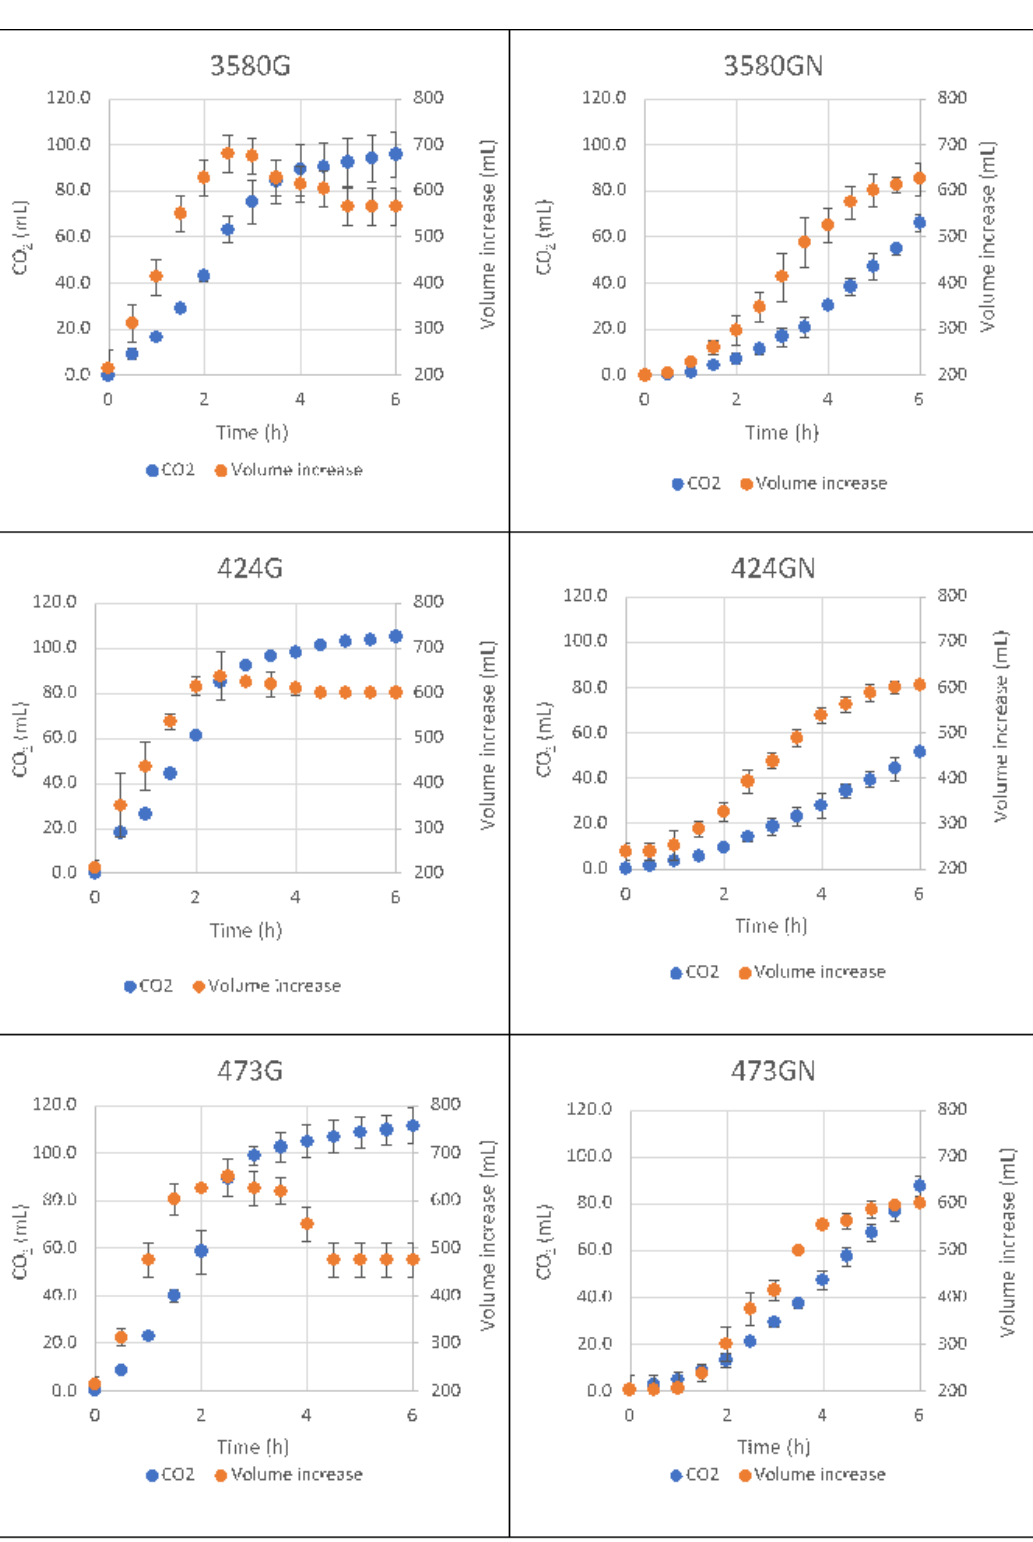
Figure 1. Time course of dough volume increase (mL) and CO 2 production (mL) in leavening trials carried out with Z. mobilis DSM 424, 3580 and 473, comparatively; doughs added with glucose (first column, G) or with glucose and NaCl (second column, N).